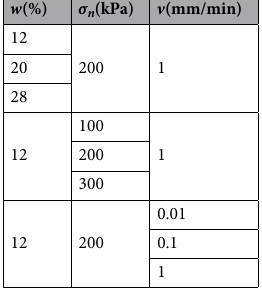
Table 2. Ring shear test scheme.